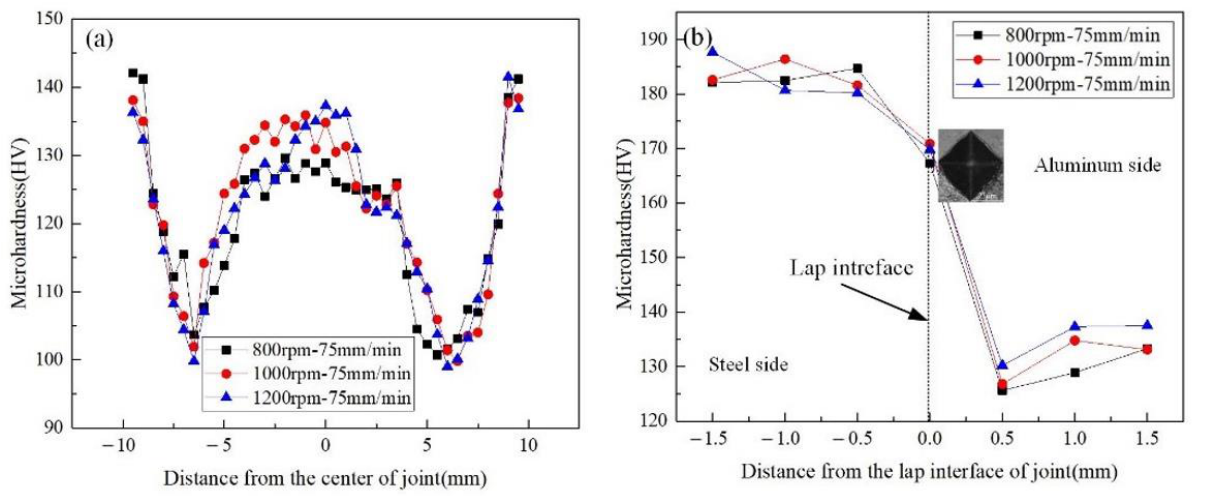
Figure 8. Microhardness distributions of joints: ( a ) horizontal direction and ( b ) thickness direction.